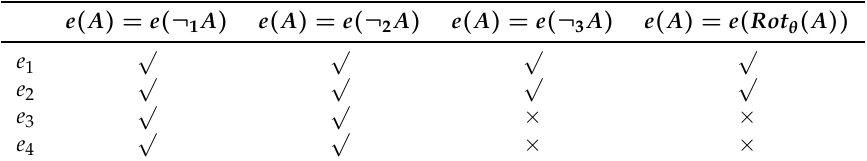
Table 1. Comparison of these entropy